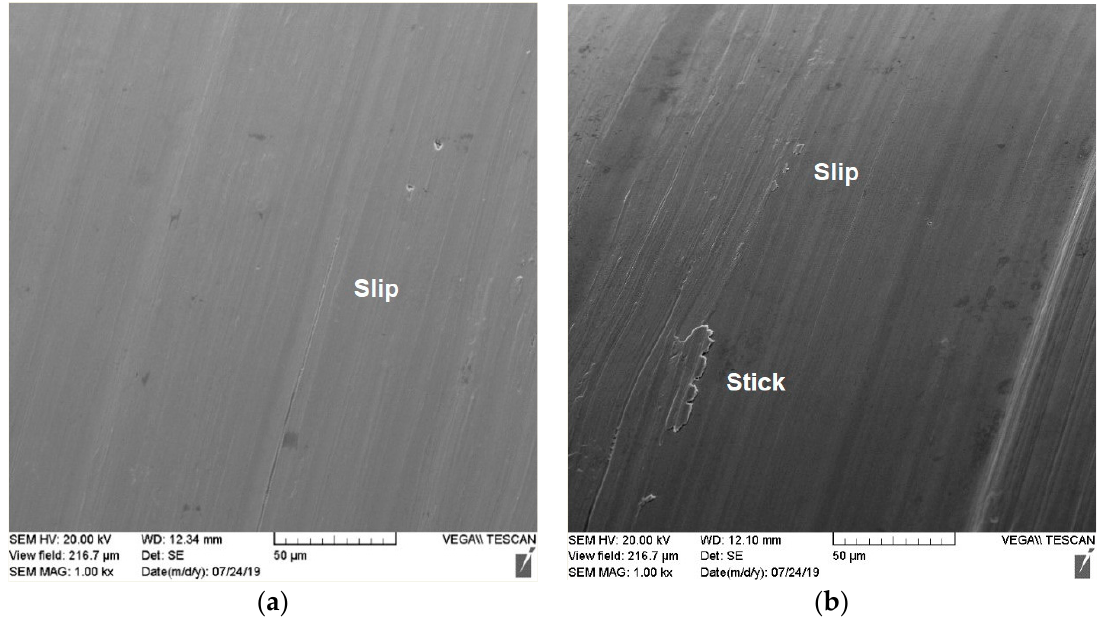
Figure 11. Chips undersurface produced by cutting tool with: ( a ) CAD and ( b ) HiPIMS coating.